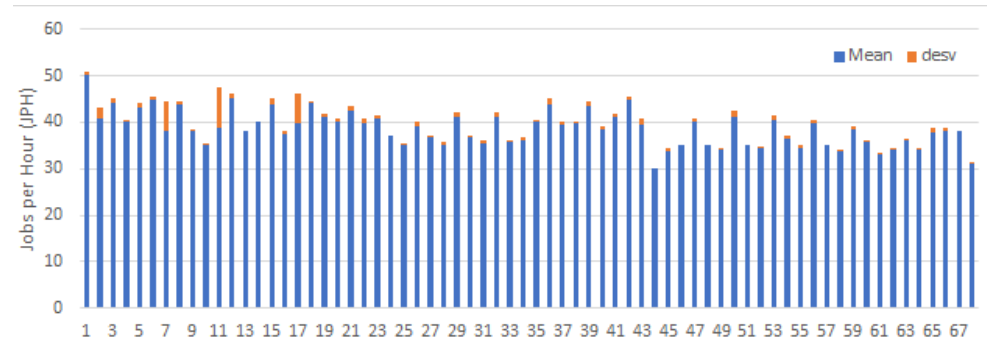
Figure 13. Jobs-per-hour for each